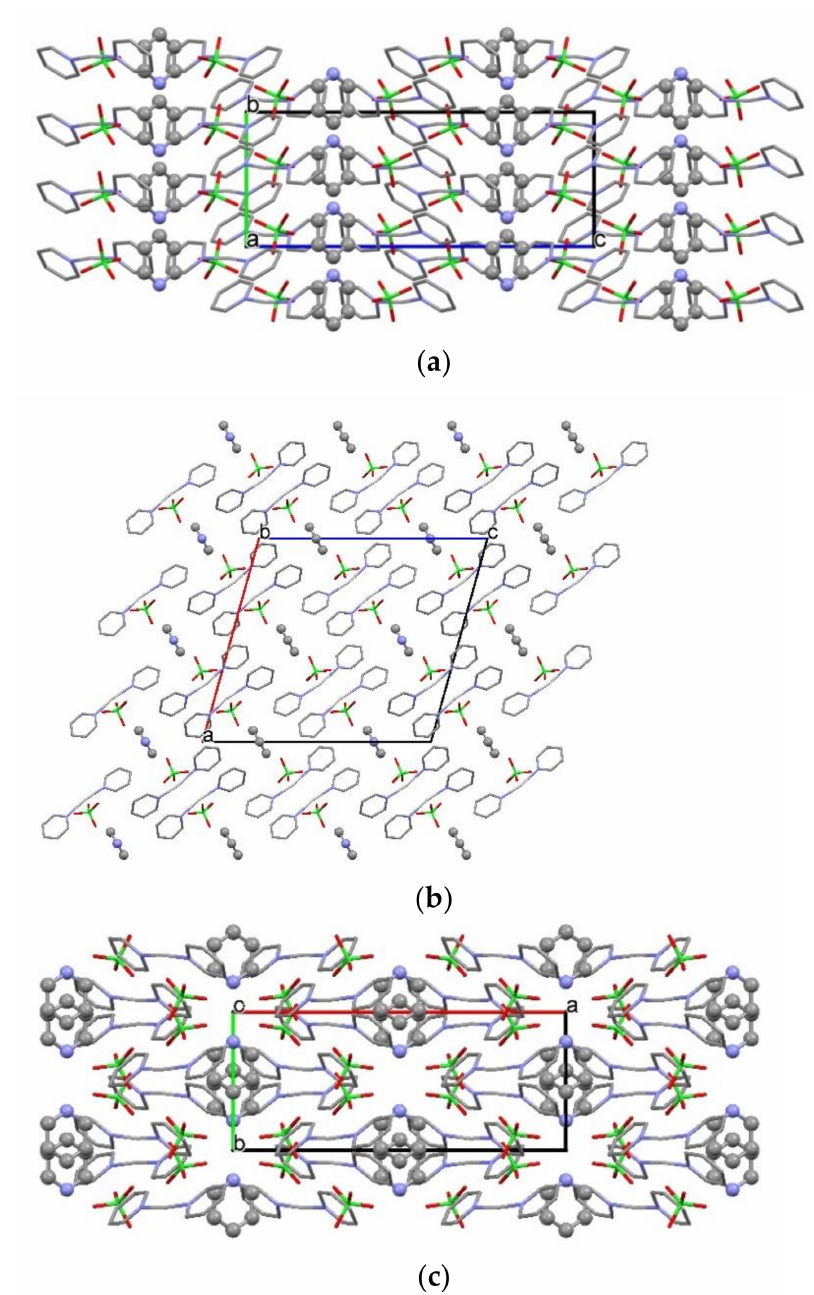
Figure 7. The packing arrangement of compound 1 (capped sticks) and the solvent pyridine (ball and stick representation). ( a ) View along the a crystallographic axis; ( b ) view along the b crystallographic axis; ( c ) view along the c crystallographic